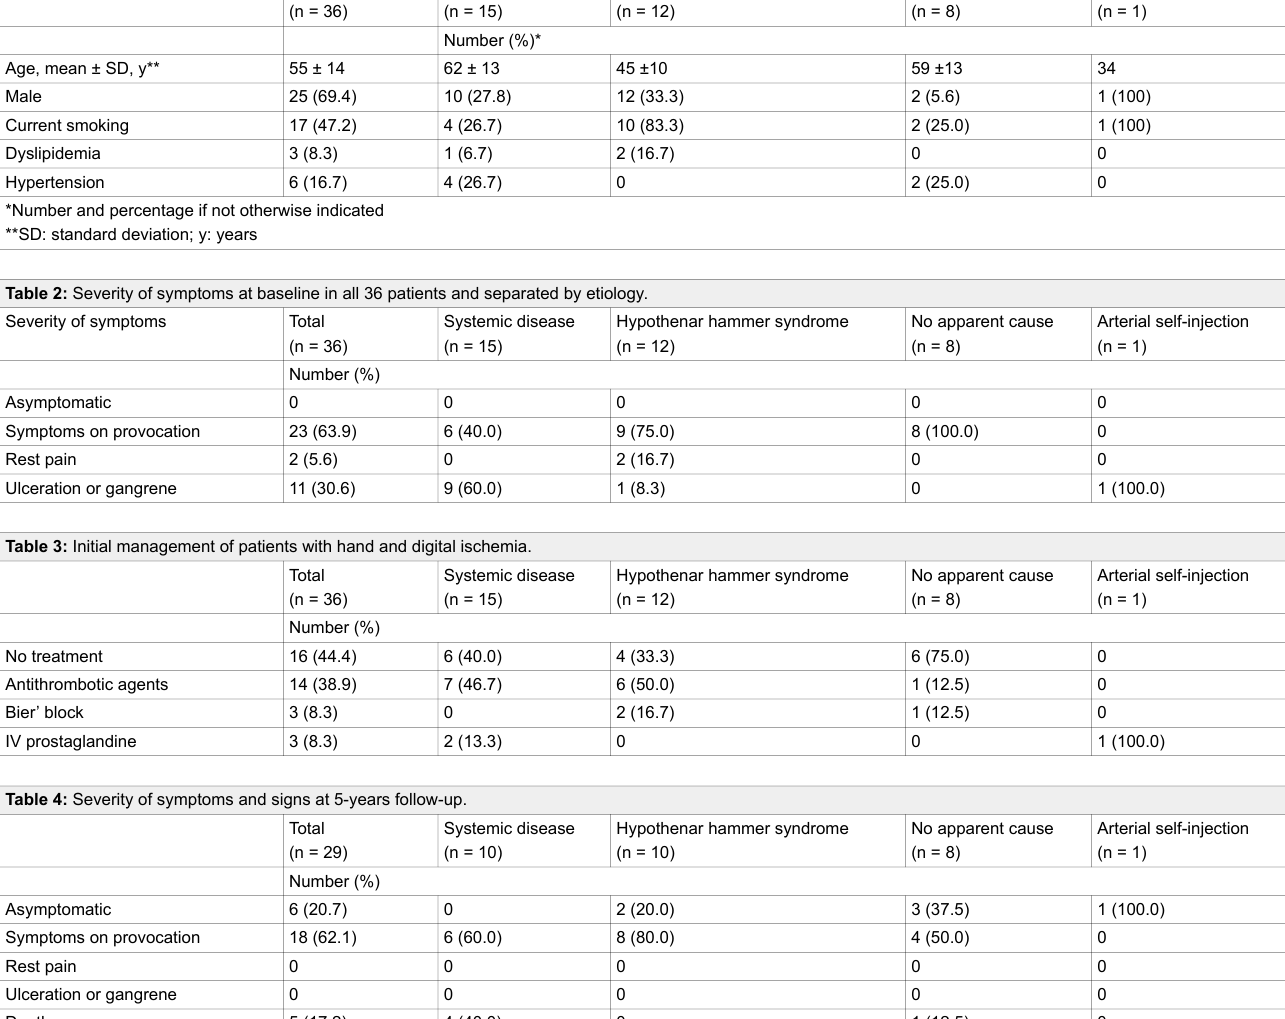
Table 1: Baseline characteristics of 36 patients with hand and digital ischemia.